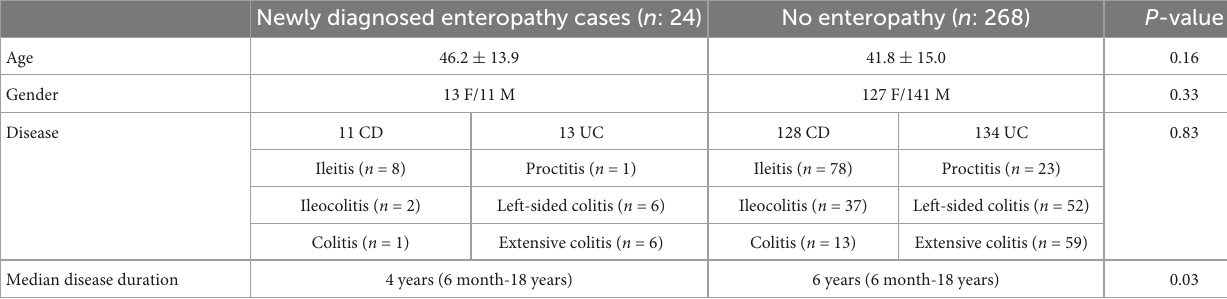
TABLE 2 Clinical characteristics of patients with newly diagnosed